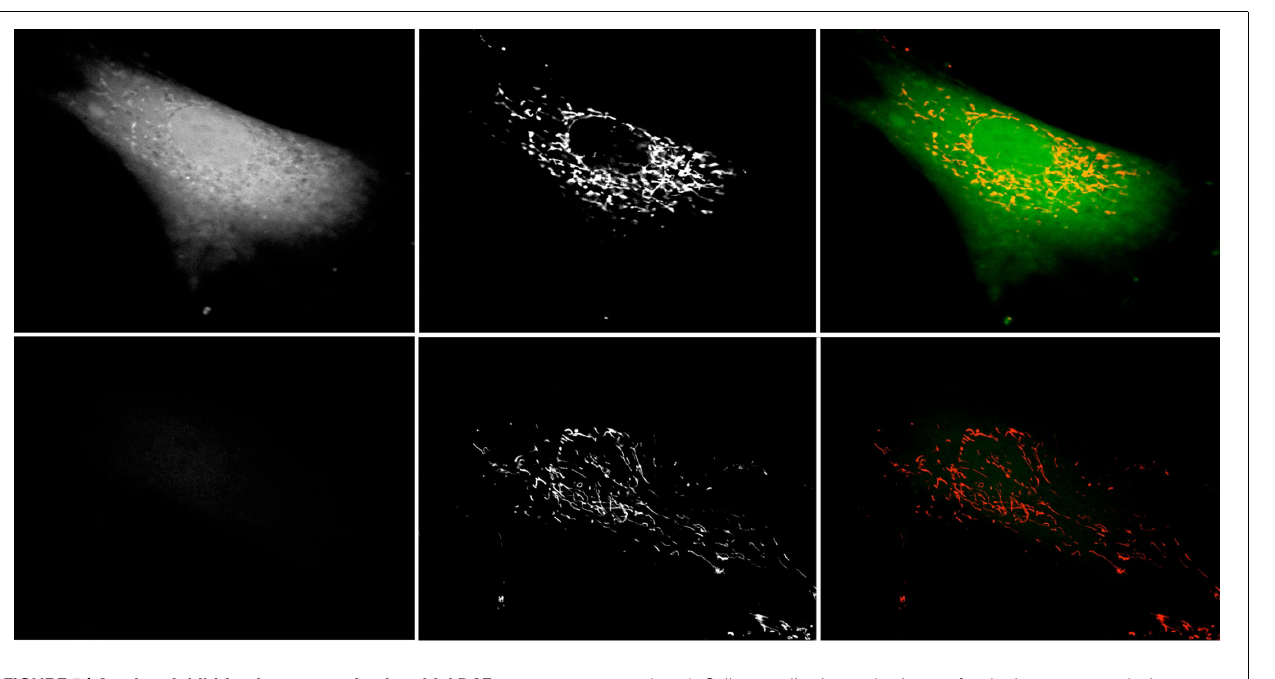
column). Cells were live-imaged using confocal microscopy employing FITC optics for DCF andTexas Red optics for MitoTracker Red. Right column is a false-color overlay of the DCF and MitoTracker images. Images are representative of numerous fields, imaged under identical